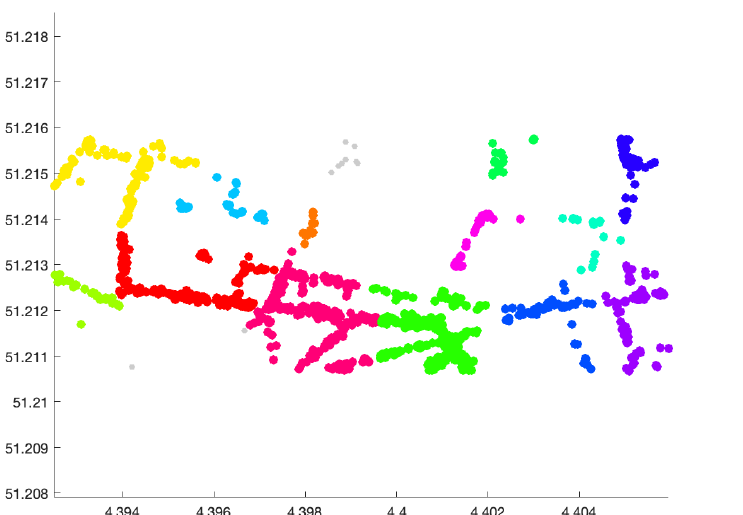
tering of a set of XY coordinates in the coordinate range Lat ∈ [ 4 ◦ 23 (cid:48) 00 (cid:48)(cid:48) ,4 ◦ 24 (cid:48) 00 (cid:48)(cid:48) ] – Long ∈ [ 51 ◦ 12 (cid:48) 00 (cid:48)(cid:48) ,51 ◦ 13 (cid:48) 00 (cid:48)(cid:48) ] , which represents the subarea corresponding to the central area of the city of Antwerp.